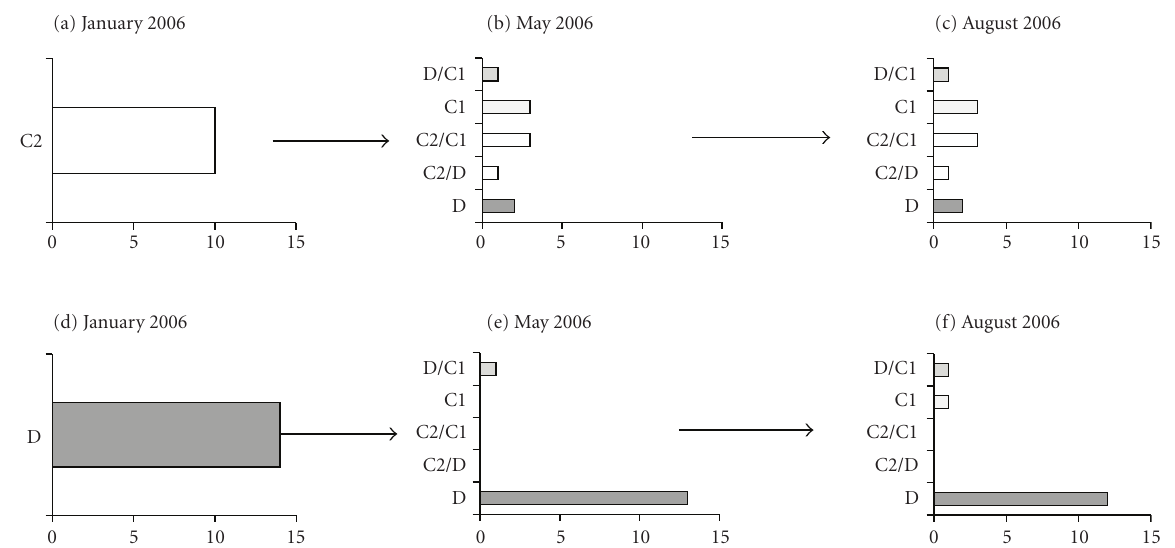
Figure 2: Symbiont community changes in colonies of Acropora millepora following a bleaching event in February 2006. (a)–(c). Two of the original 12 C2 colonies changed to type D symbionts, one colony recovered with C2 and D, one colony changed to D and C1, three colonies changed to C1, and three colonies recovered with both C2 and C1 symbionts. (d)–(f). Ten of the original D colonies retained their D symbionts, one colony changed to C1, and one colony gained C1